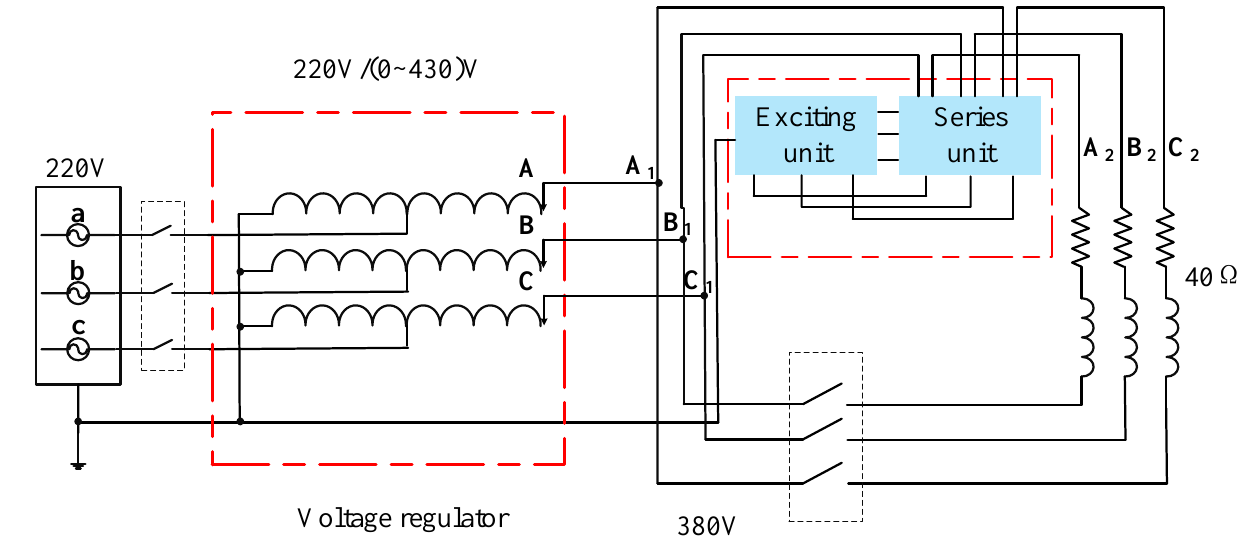
Figure 18. Experimental schematic diagram .